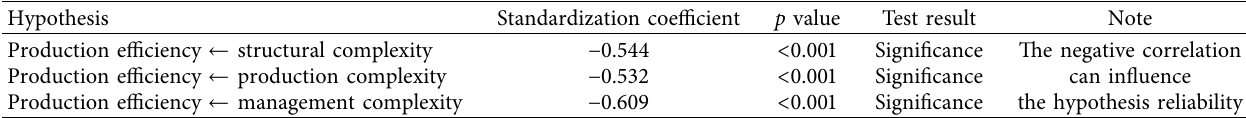
Table 11: Path coefficient and hypothesis test of the relationship between complexity index and production efficiency.